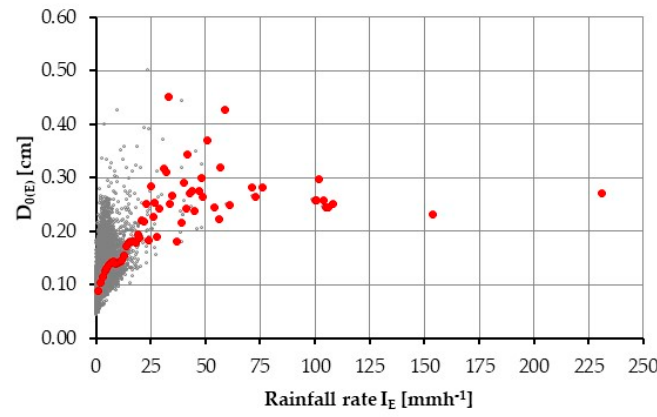
Figure 11. Relationship between the empirical values of the median volume diameter and rainfall intensity for single (grey dots) and aggregated (red dots) DSDs.